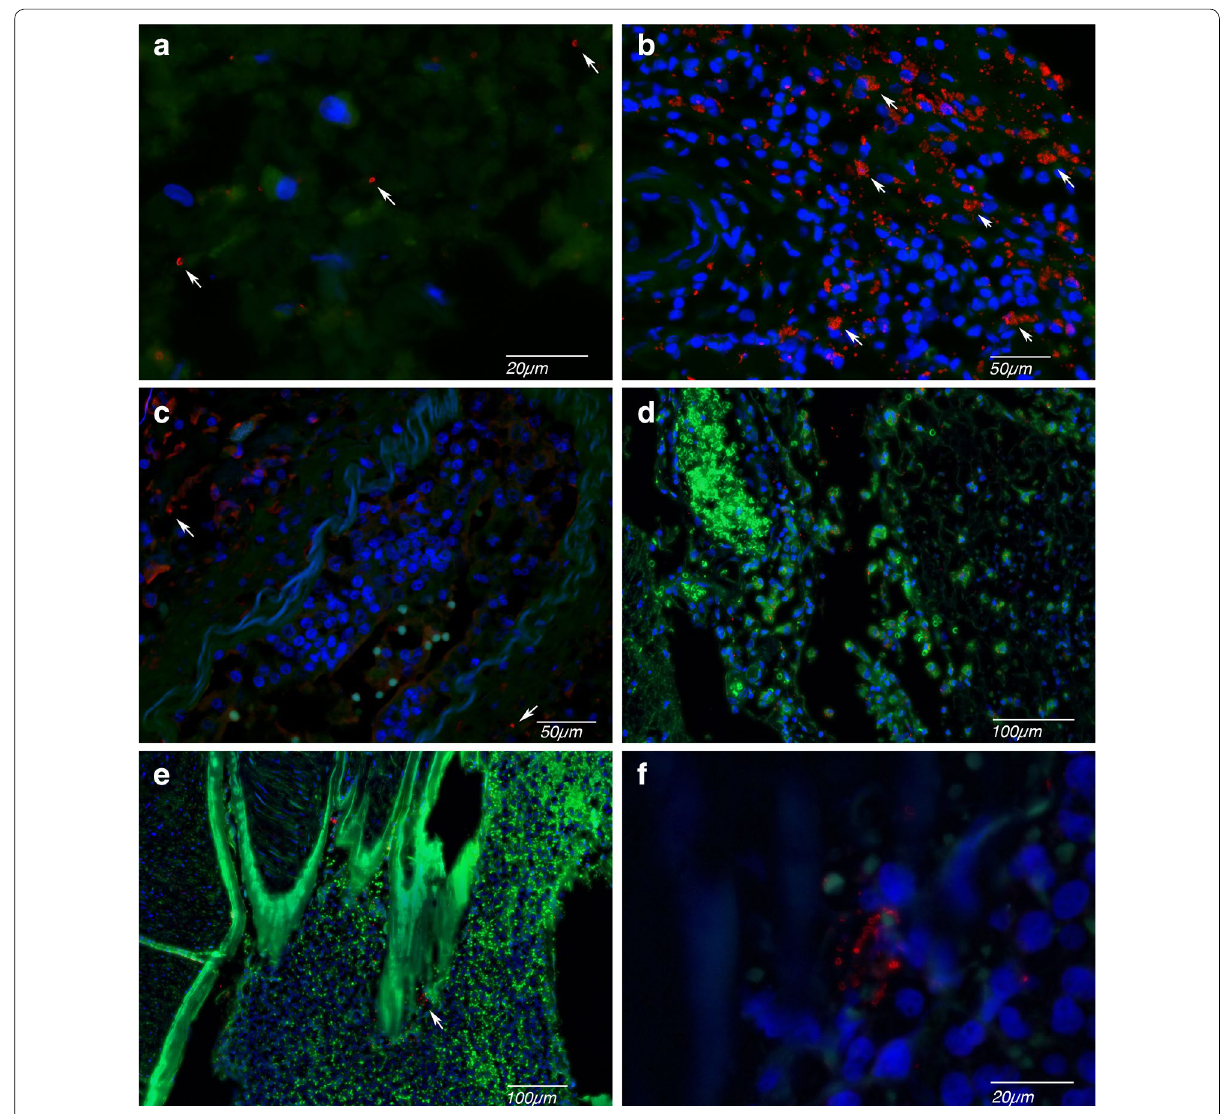
Fig. 3 Immunofluorescent analysis pneumococcal capsules of DCT patients and control meningitis patients. a – e DCT cases with the presence of various amount of intact pneumococcal capsules (a arrow). In case 1 ( a ), pneumococcal capsules were present sporadically. In case 2 ( b ), abundant presence of pneumococcal capsules was observed. In case 3 ( c ) and case 4 ( d ), a moderate amount was seen. In the thromboembolus of the basilar artery of the case 4 ( e ), large groups of bacteria were present (arrow) in addition to isolated bacteria (with mix of macrophages and neutrophils). The group of bacteria was enlarged in inlet. f Abundant presence of pneumococcal capsules in a control meningitis